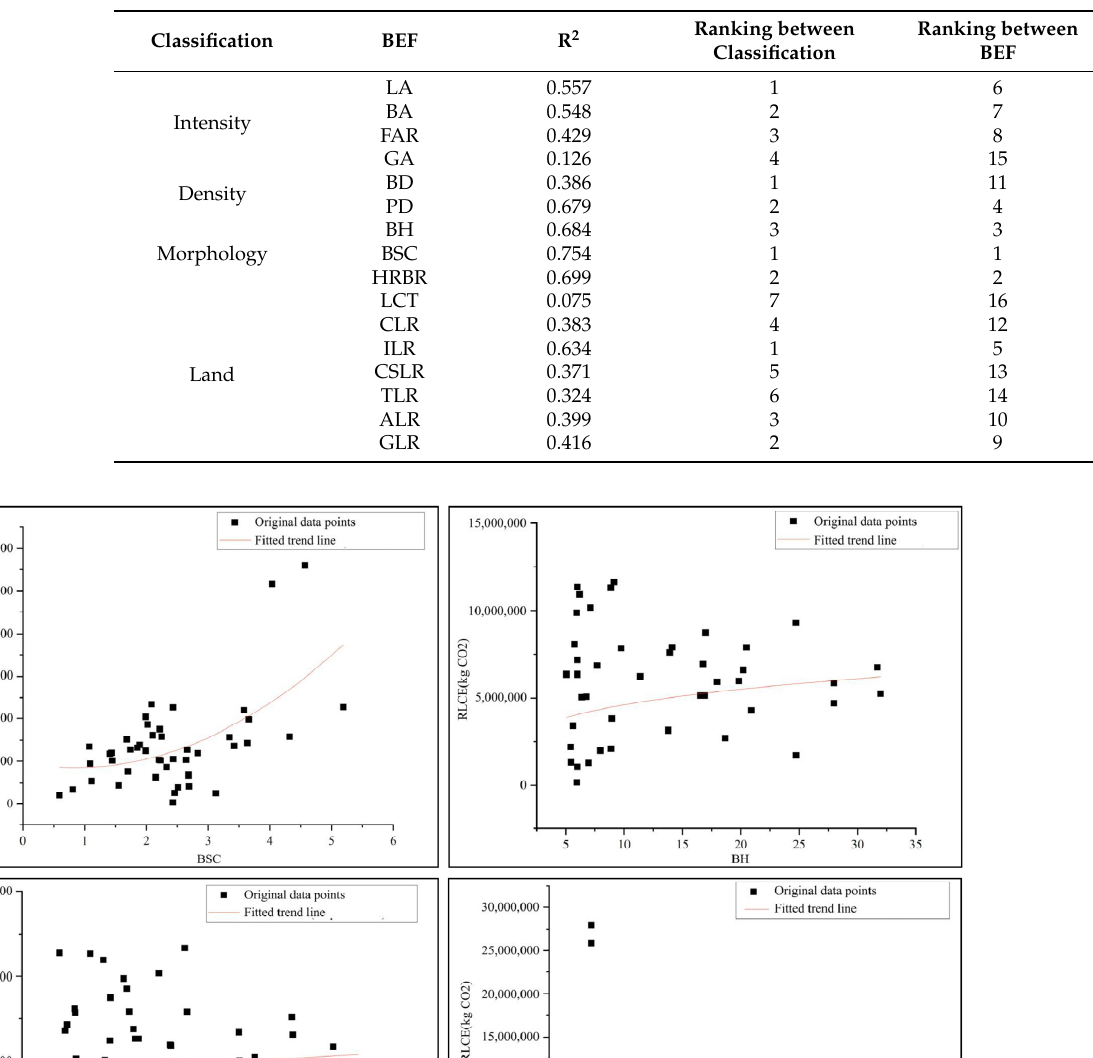
Table 4. The R 2 between BEF and RLCE.